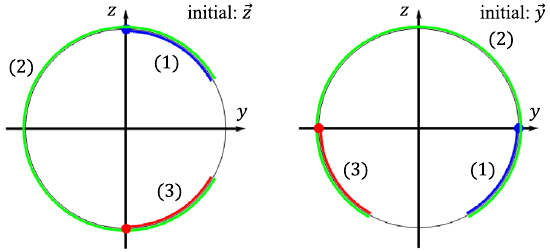
Figure 2. Errorless trajectories on the yz plane by CORPSE ( π 3 ) 0 ( 5 π 3 ) π ( π 3 ) 0 , which performs (π) 0 . The left y ) as the initial state. The initial (final) states are represented by the blue (red) points. The z ( (right) panel has (cid:31) (cid:31) blue, green, and red curves represent the first, second, and third pulse trajectories, respectively. The left (right) y ) as the initial z ( panel has (cid:31) (cid:31)